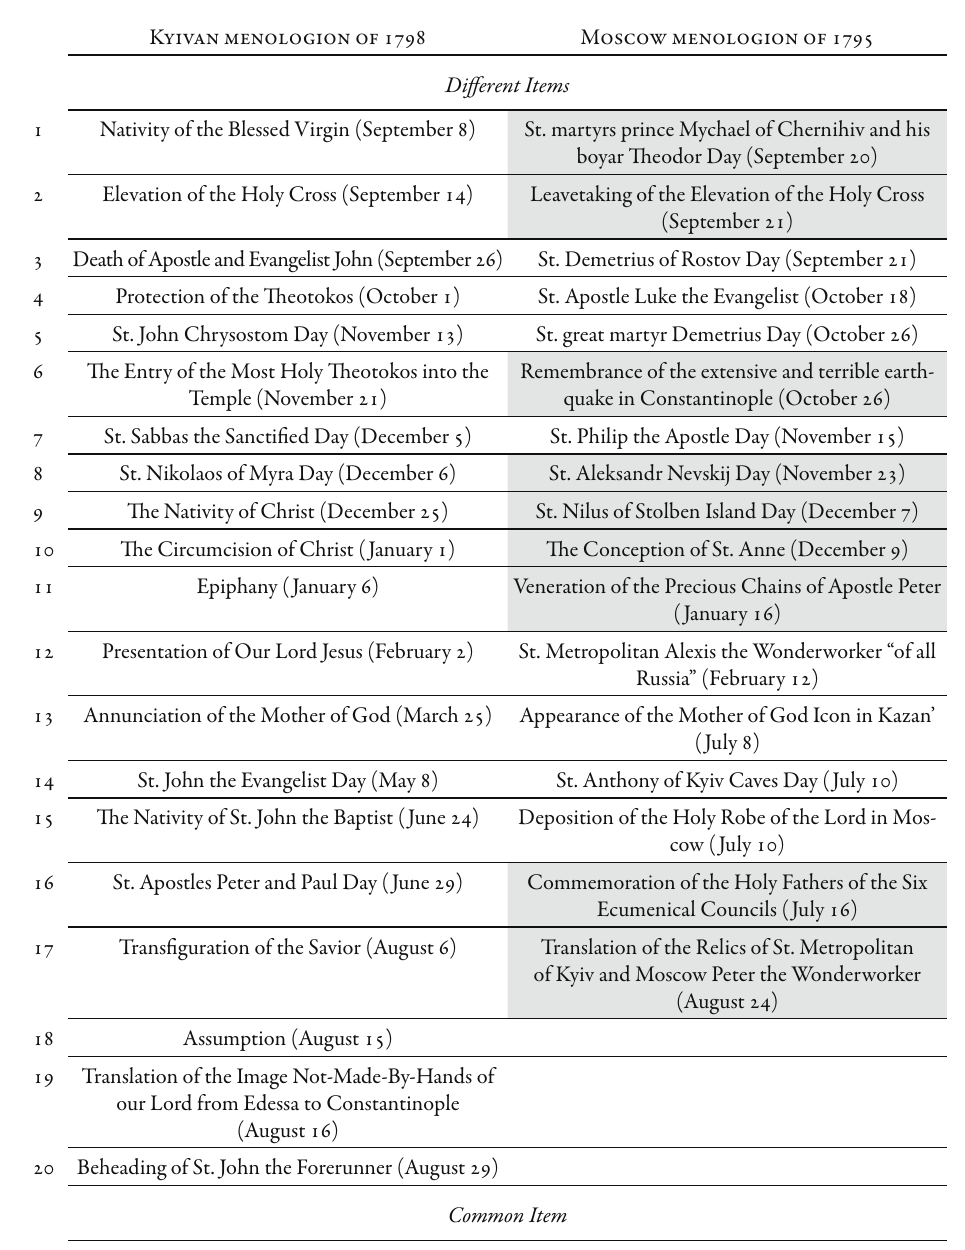
Table 1. The most solemn feasts in Kyivan and Moscow calendars ( The gray color indicates the ordinary feasts in the Kyivan calendar. All dates follow the Julian calendar